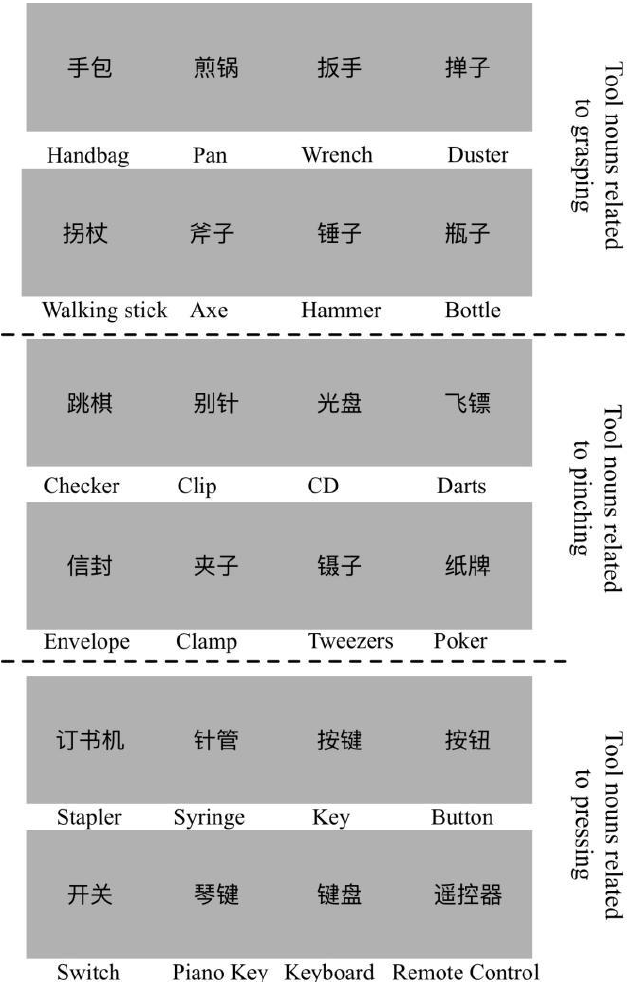
Figure 1. The selected stimuli used in the fMRI experiment with high action consistency and familiarity. Twenty-four object nouns were selected, and the written noun words were scaled to 256 × 256 pixels with a light grey background. The corresponding English words are below each stimulus. For example, the “ 手 包 ” in Chinese is the “handbag”. Each of the eight object nouns were highly correlated with grasping, pinching or pressing.